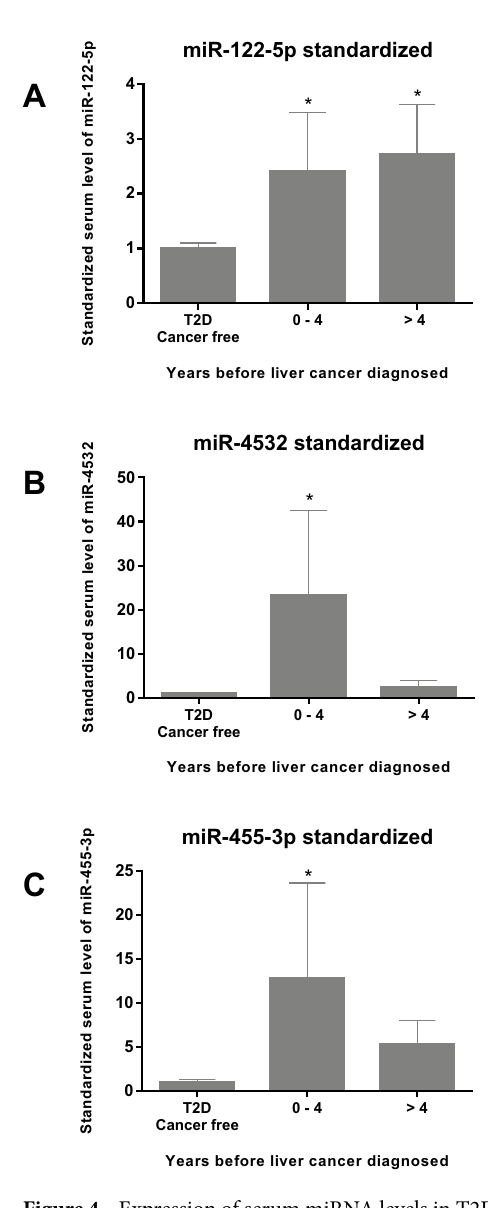
Figure 4. Expression of serum miRNA levels in T2D liver cancer patients. Serum levels of miR-122-5p ( A ), miR-4532 ( B ) and miR-455-3p ( C ) are shown. The T2D liver cancer patients were categorized by the length of the period between the enrolment dates in HKDR and their first liver cancer diagnosis. The serum levels of the miRNAs are standardized to the mean serum levels of the T2D cancer free patients. The bar chart with error bars represent the mean ± standard deviation. * P < 0.05 when comparing to the T2D cancer free